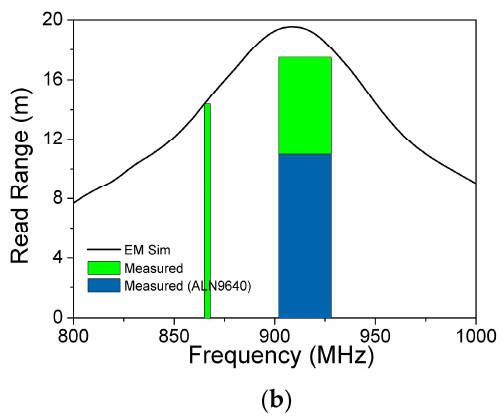
Figure 6 . ( a ) Manufactured tag prototype; ( b ) Simulated and measured read range of the fabricated 1.25 wavelength long dipole antenna tag.